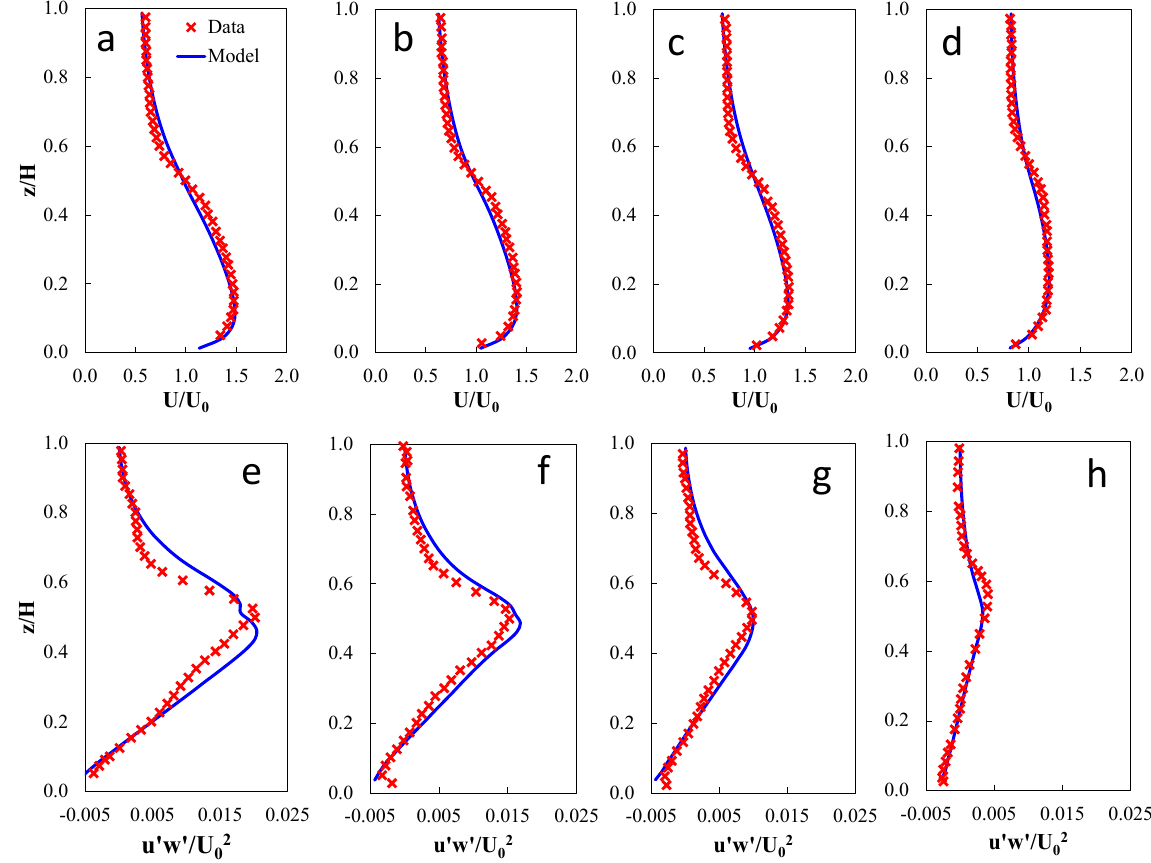
Figure 4. ( a – d ) Model-data comparisons of normalized mean vertical velocity profiles for Validation Runs A, B, C, and D, respectively. ( e – h ) Model-data comparisons of normalized mean turbulent stress profiles for Validation Runs A, B, C, and D,